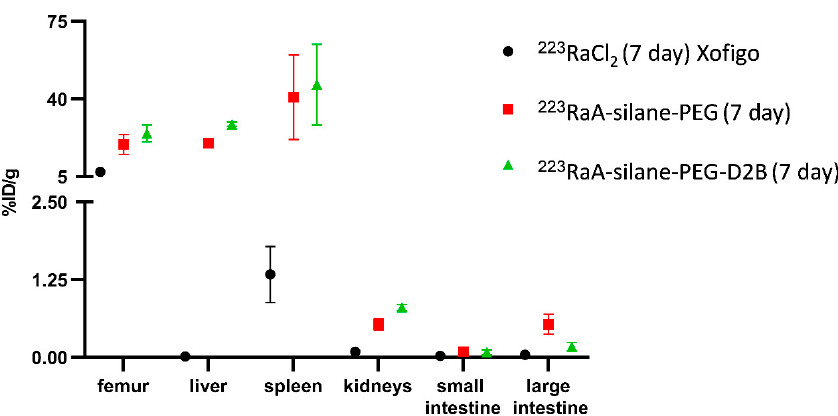
Figure A1. Elimination of radioactivity from blood of BALB/c mice injected intravenously (tail vein) with 133BaA-silane-PEG (black line) and 133BaA-silane-PEG-anty-PSMA (red line).